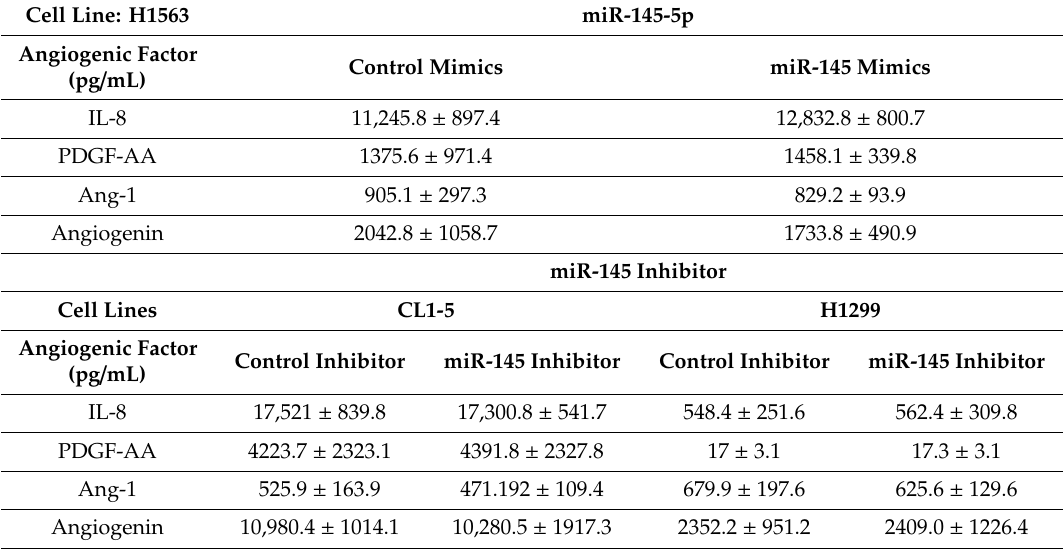
Table 2. The e ff ect of miR-145-5p in the expression of various pro-angiogenic factors in lung